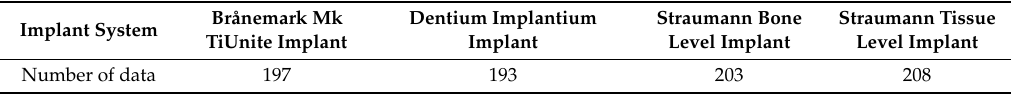
Table 1. Implant type and data number.